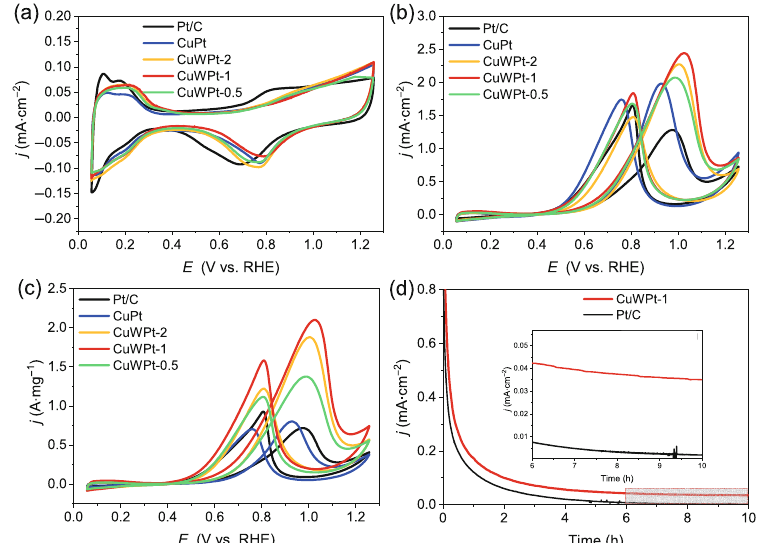
Figure 4 (a) CVs of ternary CuWPt-2, CuWPt-1, CuWPt-0.5, binary CuPt alloy nanoparticles and commercial Pt/C catalyst in N 2 -saturated 0.1 M HClO 4 ; (b) ECSA-based CVs of same catalysts in 0.1 M HClO 4 containing 1 M methanol; (c) Pt mass-based CVs of same catalysts in 0.1 M HClO 4 containing 1 M methanol; (d) chronoamperometric curves and their partial enlargement (inset) of ternary CuWPt-1 nanoparticles and commercial Pt/C catalyst at 0.63 V in 0.1 M HClO 4 solution containing 1 M